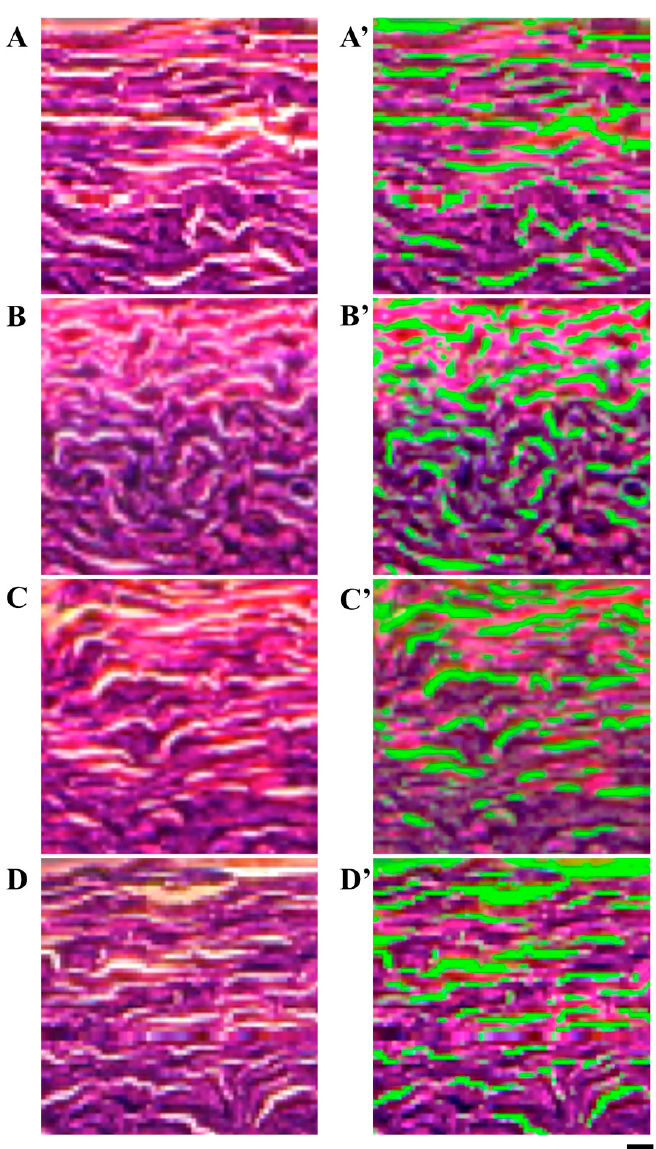
Figure 4. Improvements in stratification of UVB-exposed skin during di ff erentiation, after treatment with S. europaea extract. Light microscopic images of the cross section of hematoxylin-eosin-stained keratinocytes located in the stratified region (the upper region) of a multilayered, highly di ff erentiated in vitro skin model. ( A ) Control keratinocytes; ( B ) UVB-exposed keratinocytes; ( C ) control keratinocytes after treatment with S. europaea ; and ( D ) UVB-exposed keratinocytes after treatment with S. europaea . Typical morphological features in the stratification are indicated with green lines ( A’ – D’ ). Scale bar, 10 µm.